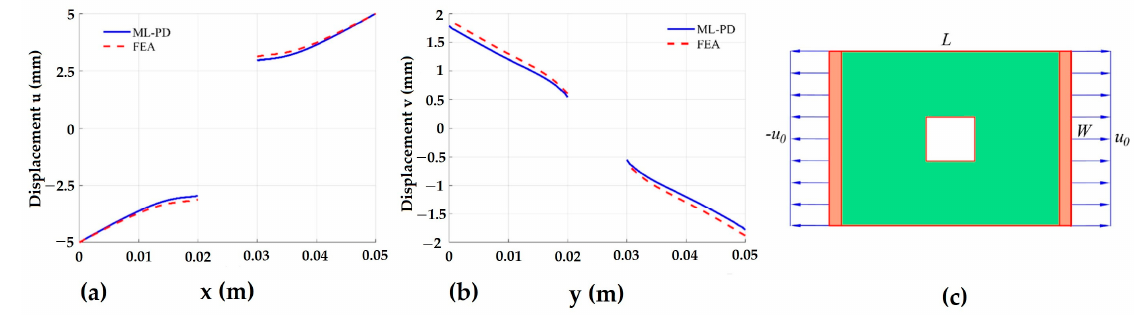
Figure 12. Variation of displacement along ( a ) y and ( b ) x. ( c ) Geometry of plate [76].